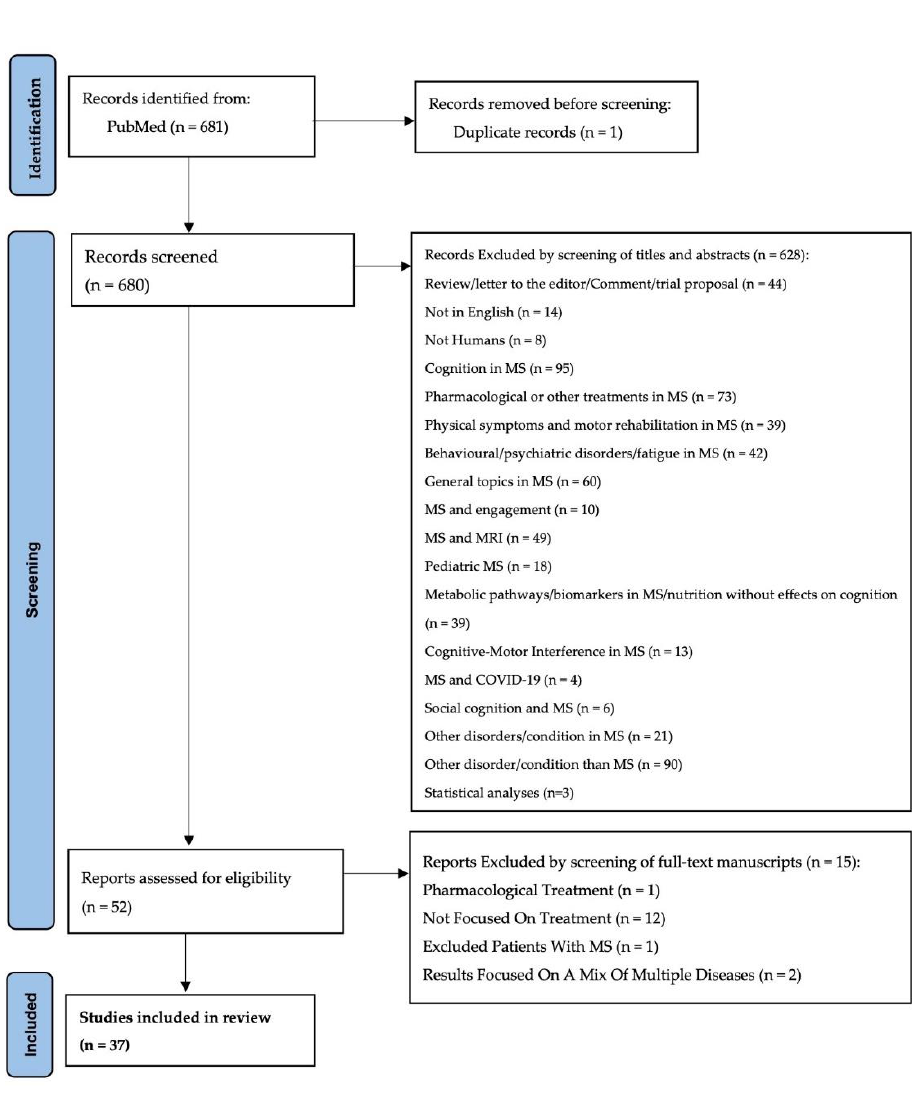
Figure 1. Flowchart of the study selection process. Table 1. Type of non-pharmacological treatments of